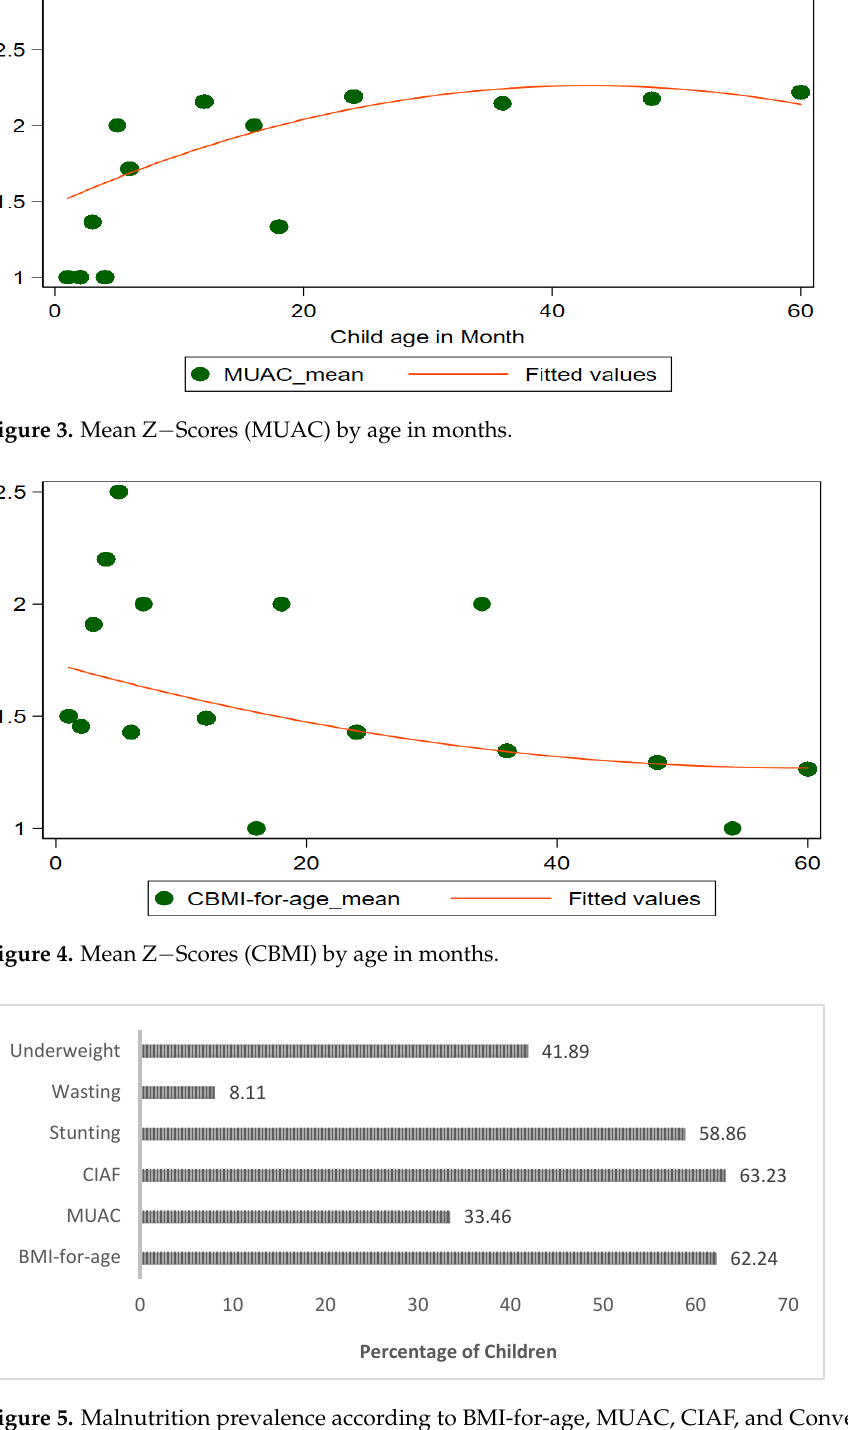
Table 3. Overall Malnutrition Prevalence (Frequencies and percentages) among children through different approaches. Indicators Frequencies and Percentages BMI-for-age Normal = 133 (25.73%); Undernutrition = 321 (62.24%); Overweight = 12 (2.32%); Obesity = 14(2.71%) MUAC Normal = 213 (44.68%); Moderate Undernutrition (MAM) = 113 (21.86%); Severe Undernutrition (SAM) = 173 (33.46%) CIAF Normal = 114 (36.77%) Malnourished = 196 (63.23%) Stunting Normal = 81 (30.34%); Moderate = 93 (34.83%); Severe = 93 (34.83%) Underweight Normal = 78 (29%); Moderate = 67 (24.91%); Severe = 124 (46.10%) Wasting Normal = 39 (54.93%); Moderate = 21 (29.58%); Severe = 11 (15.49%) The results in Figure 6 show the multiple anthropometric failures according to the subgroups of CIAF classification among children. The results showed that stunting prev- alence was 23.79%, underweight was 21.08%, and wasting was 0.39% using CIAF classifi- cations. Other anthropometric disorders are also explained by CIAF in Figure 6.